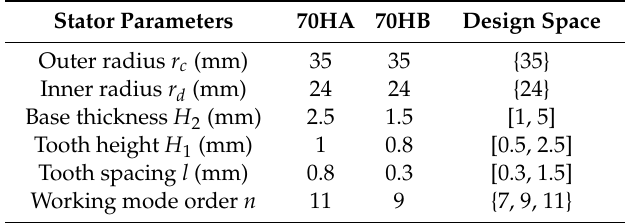
Table 2. Comparison of the stator characteristic parameters of 70HA and 70HB.